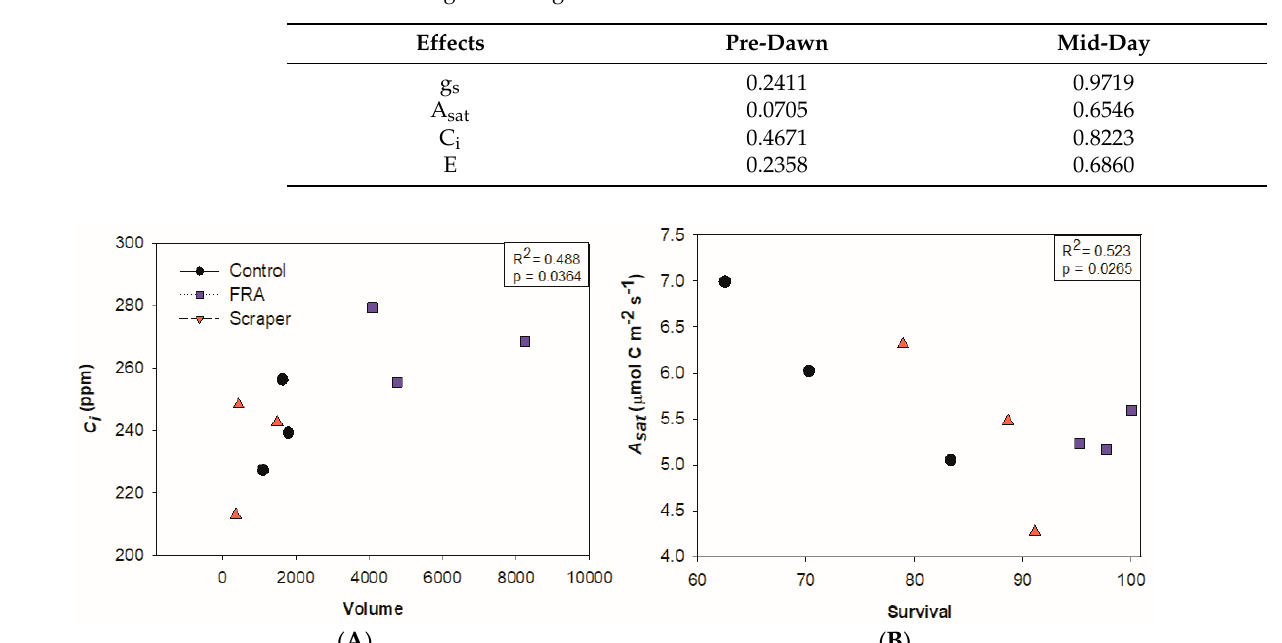
Table 7. p -values of pre-dawn and mid-day mean water potential from simple linear regressions with mean leaf-level gas exchange measurements.